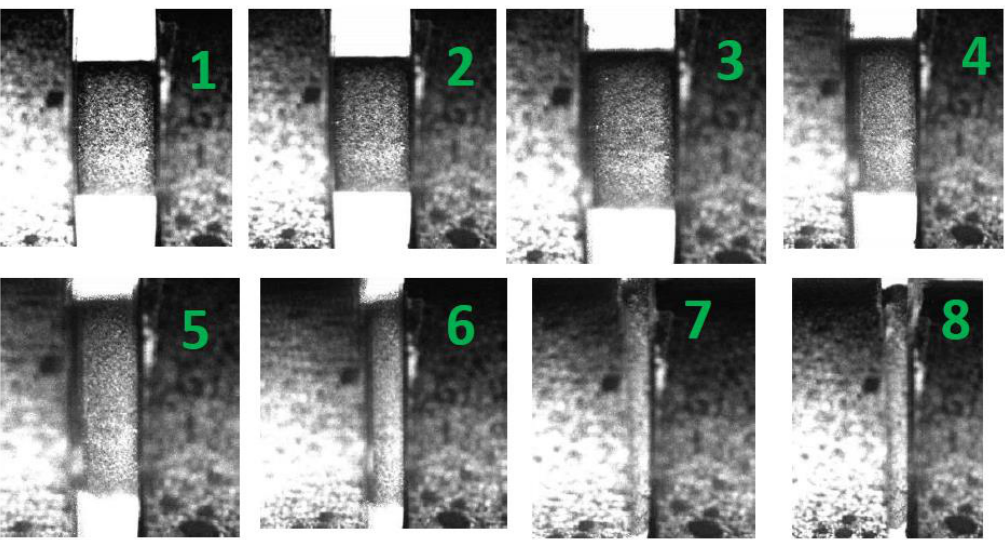
Figure 8. Deformation and fracture processes of H-80W recorded by a high-speed digital camera under the strain rate of 6100 s −1 , the green numbers in the images correspond to the numbers marked in Figure 7.